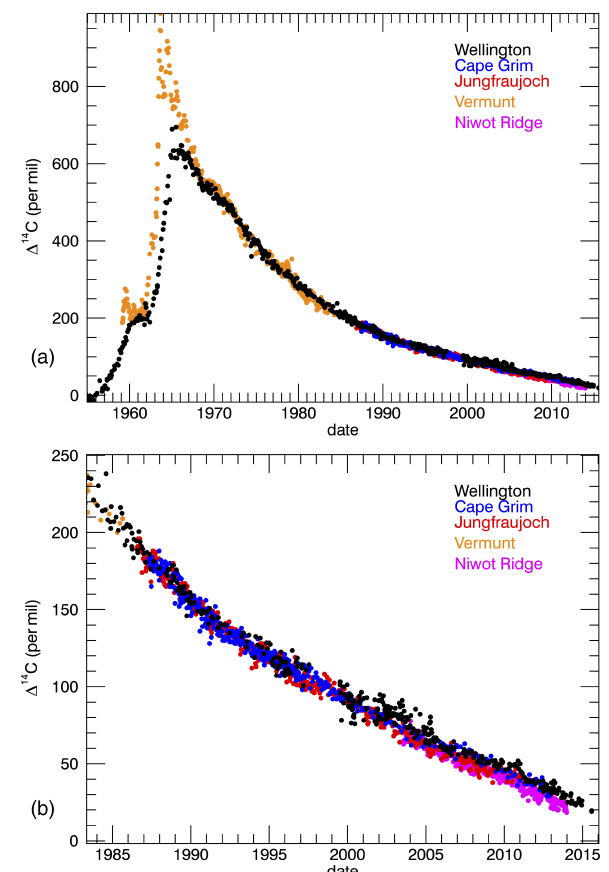
Figure 5. Comparison of Wellington and other atmospheric (cid:49) 14 CO 2 records (Levin et al., 2010; Turnbull et al., 2007; Lehman et al.,